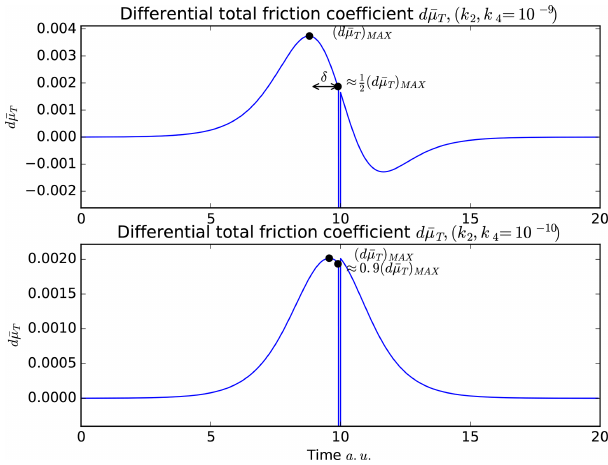
Figure 13. Different ruptures times viewed from the differential to- tal friction coefficient d µ T and using different values of k 2 and k 4 . The rupture occurs after the maximum differential total friction co- efficient ( d µ T ) MAX , when d µ T have values close to 0.5–0.9 times ( d µ T ) MAX .